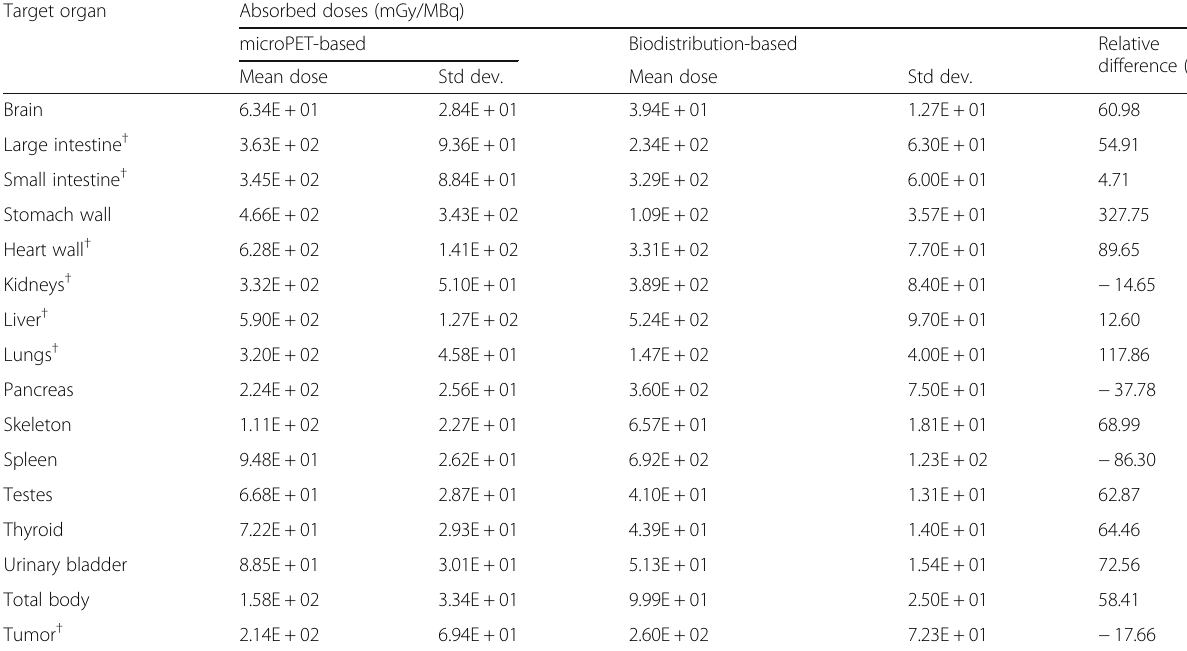
† Indicates organs that were segmented on microPET/CT imaging, for which the comparison between dose obtained with the two methods appears more meaningful. As regards dosimetry data to the heart, however, it should be noted that imaging-based data were obtained by manual contouring of both the heart wall and the heart content (see example of image segmentation in Fig. 2)